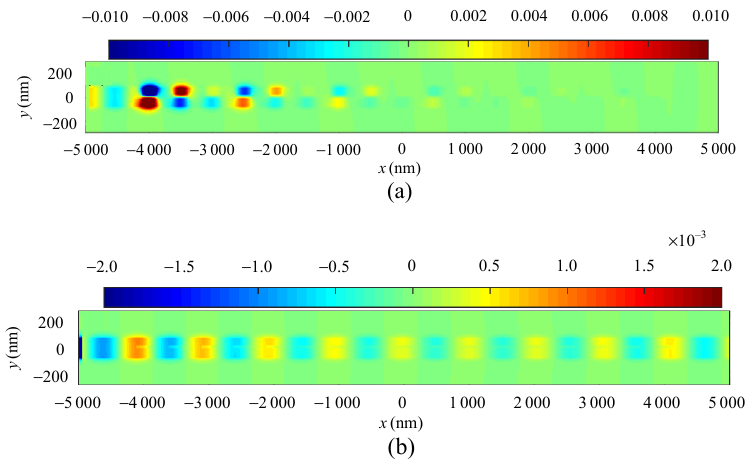
Fig. 7 Field distributions corresponding to Fig. 6(a) with L a = 240 nm and P = 500 nm: (a) MZI dip of 921 nm and (b) Bragg reflection dip of 1 224 nm.